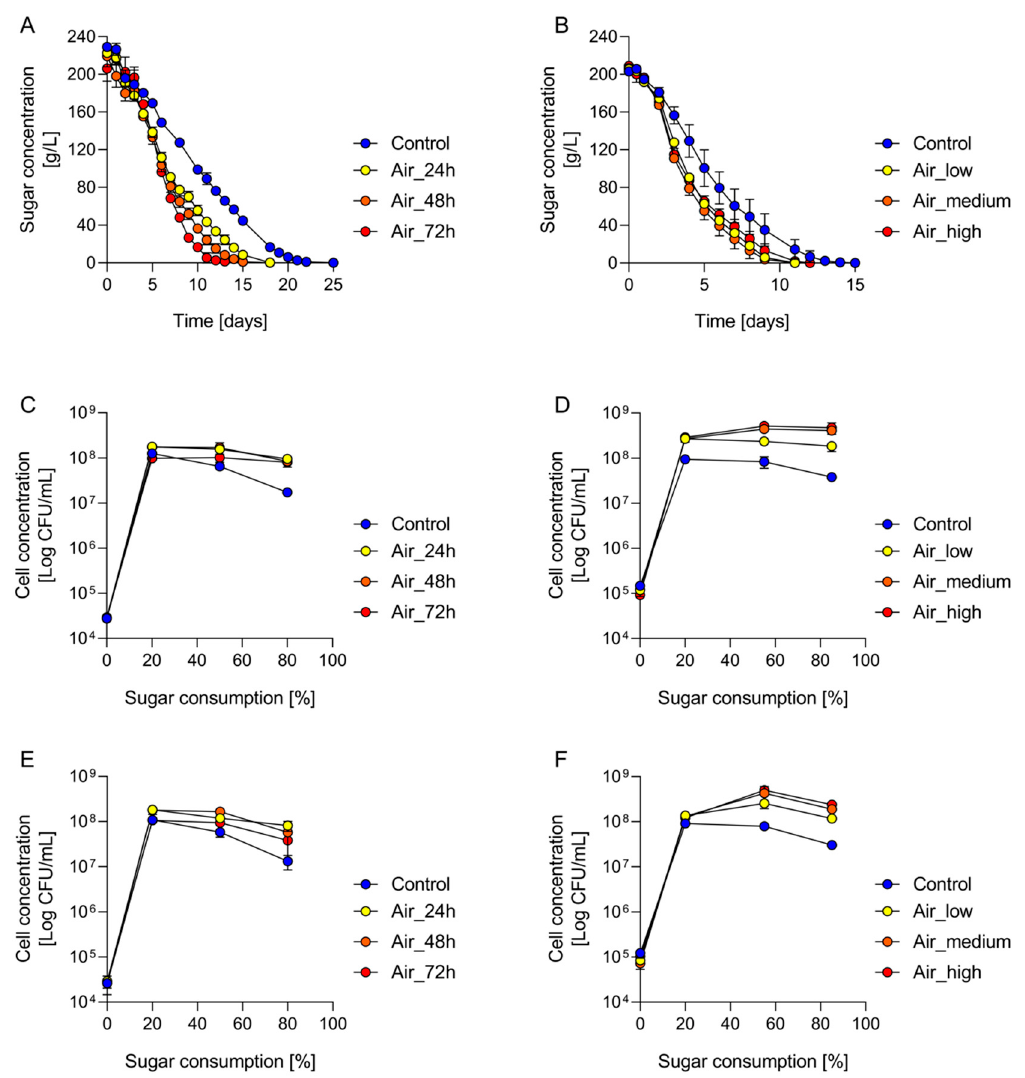
Figure 1. The effect of aeration on fermentation kinetics ( A , B ), total viable yeast counts ( C , D ) and non- Saccharomyces viable counts ( E , F ) for the different aeration treatments during 2019 ( A , C , E ) and 2020 ( B , D , F ) vintages. All symbols show means of three treatments with error bars showing SD.